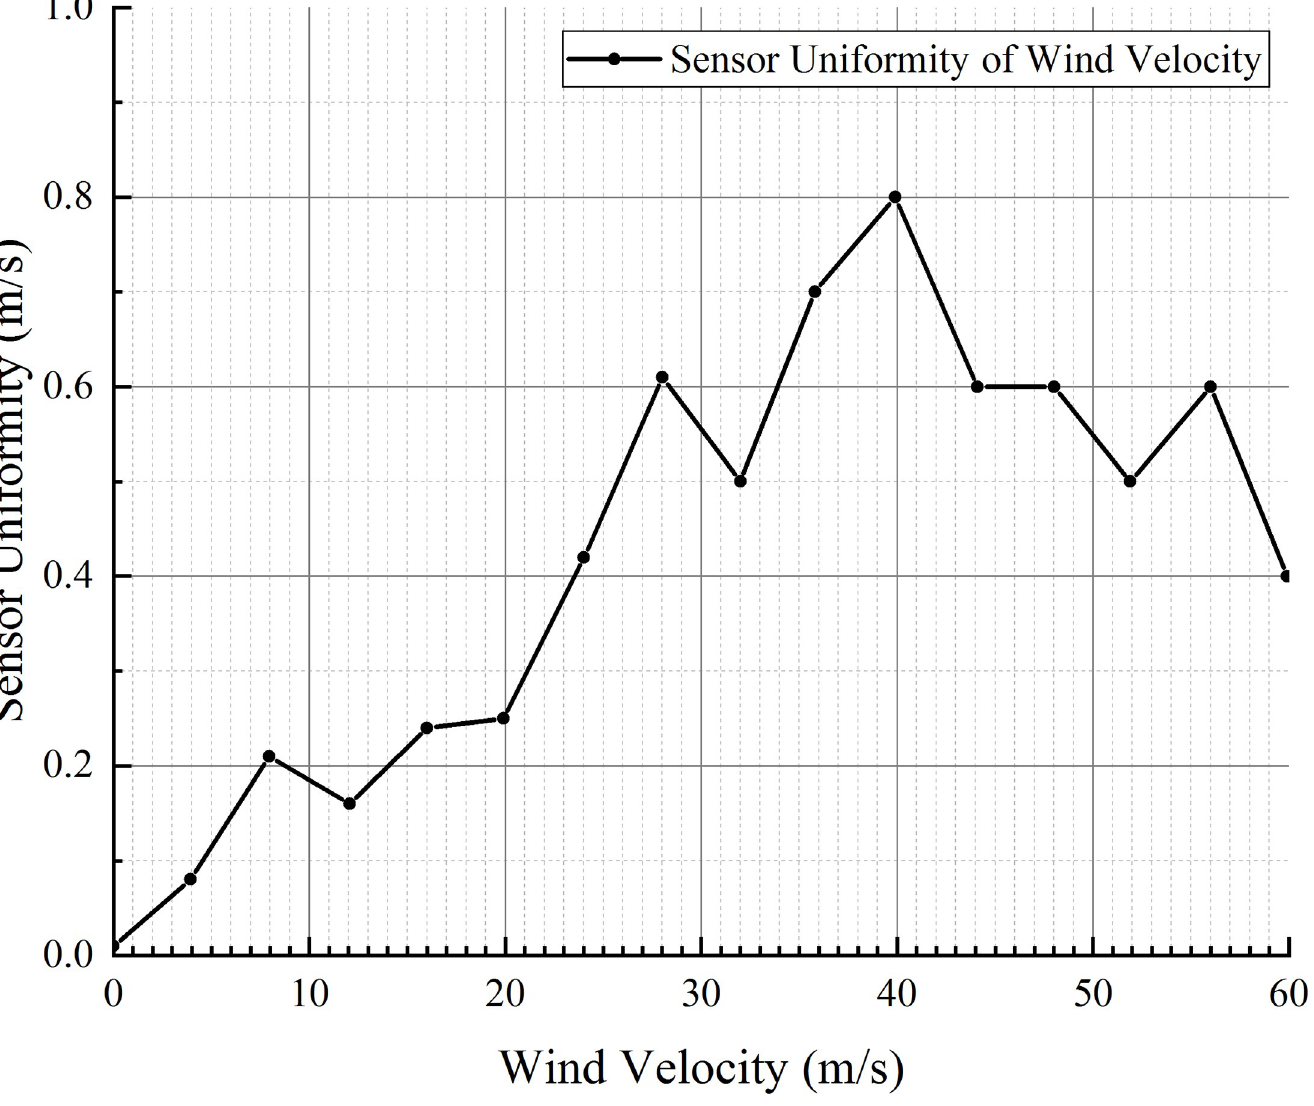
Fig 15. Consistency of the three